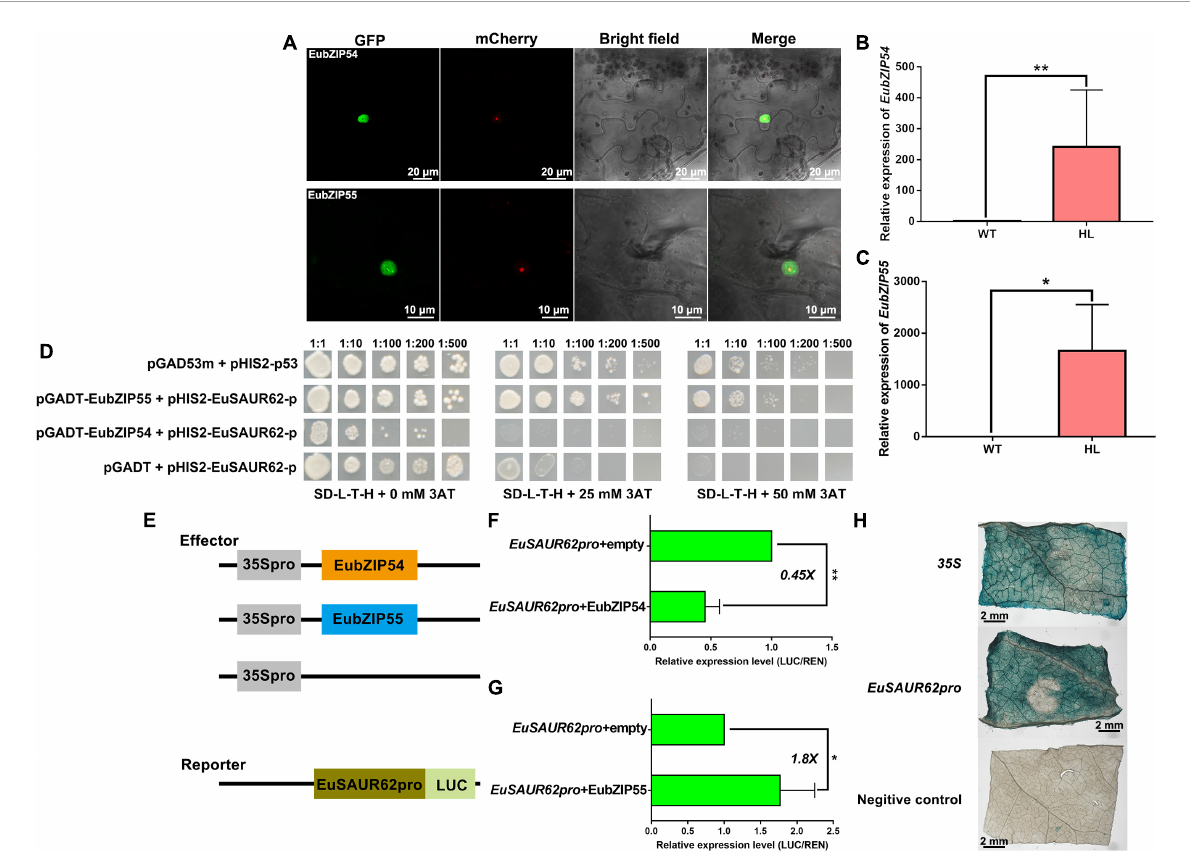
FIGURE7 EubZIP55 activates expression of EuSAUR62 . (A) The subcellular localization of EubZIP54/55 in tobacco leaves. EubZIP54/55 were fused to GFP and transfected into tobacco leaves. Merged images including bright field, H2B-mCherry, and GFP fluorescence were observed using a confocal laser scanning microscope. Relative expression of EubZIP54 (B) and EubZIP55 (C) in the fruits of WT and HL was detected using qRT-PCR. (D) Yeast one-hybrid assay for the DNA-protein interaction between the EuSAUR62pro and EubZIP54 or EubZIP55. The indicated constructs were transformed into yeast reporter strain Y187 and grown on SD–L-T-H media with different concentrations of 3-AT. pGADm53 vs. pHIS-p53 was used as a positive control, and pGADT7 vs. pHIS- EuSAUR62pro was used as a negative control. Schematic design is shown on the left (E) . Transcription repression and activation activity of EubZIP54 (F) and EubZIP55 (G) on EuSAUR62 , respectively, which is expressed by the ratio of firefly luciferase to Renilla luciferase (LUC/REN). (H) GUS activity of EuSAUR62pro and 35S promoter was compared in tobacco leaves (Scale bar = 2 mm). p35S:GUS was used as a positive control, and empty:GUS was used as a negative control. Two-tail Student’s t -test was used for statistical analysis; Data are mean ± SD. * p < 0.05, ** p < 0.01. EuSAUR62pro , EuSAUR62 promoter; HL, hybrid Euryale lines; WT, wild type (North Gordon